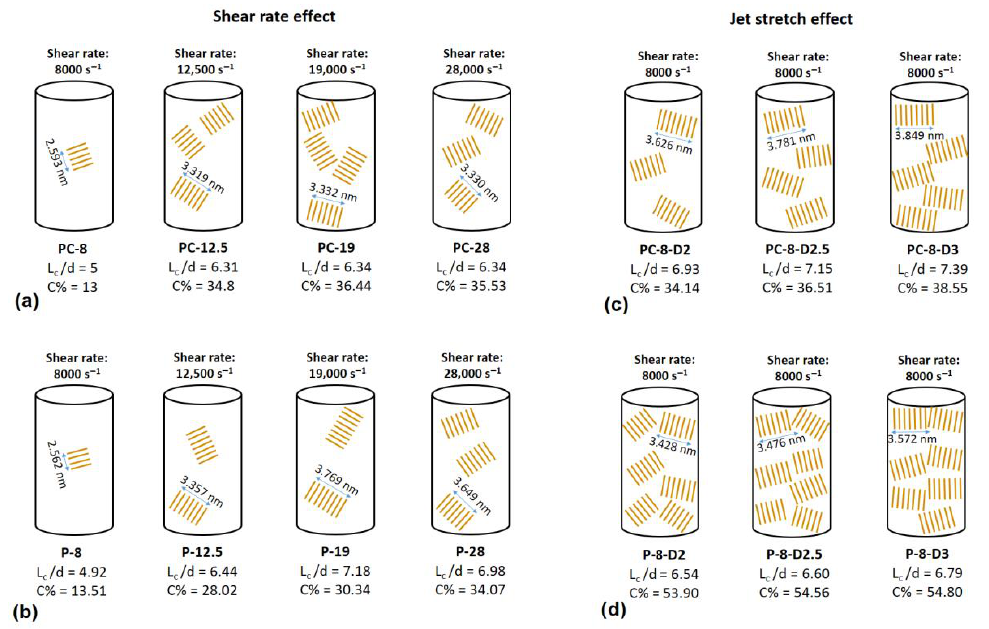
Figure 7. A schematic showing the changes in crystalline parameters of PAN and PAN/CNT fibers at different spinning conditions ( a ) PAN/CNT fibers at different shear rates, ( b ) PAN fibers at different shear rates, ( c ) PAN/CNT fibers at different jet stretch ratios, ( d ) PAN fibers at different jet stretch ratios.